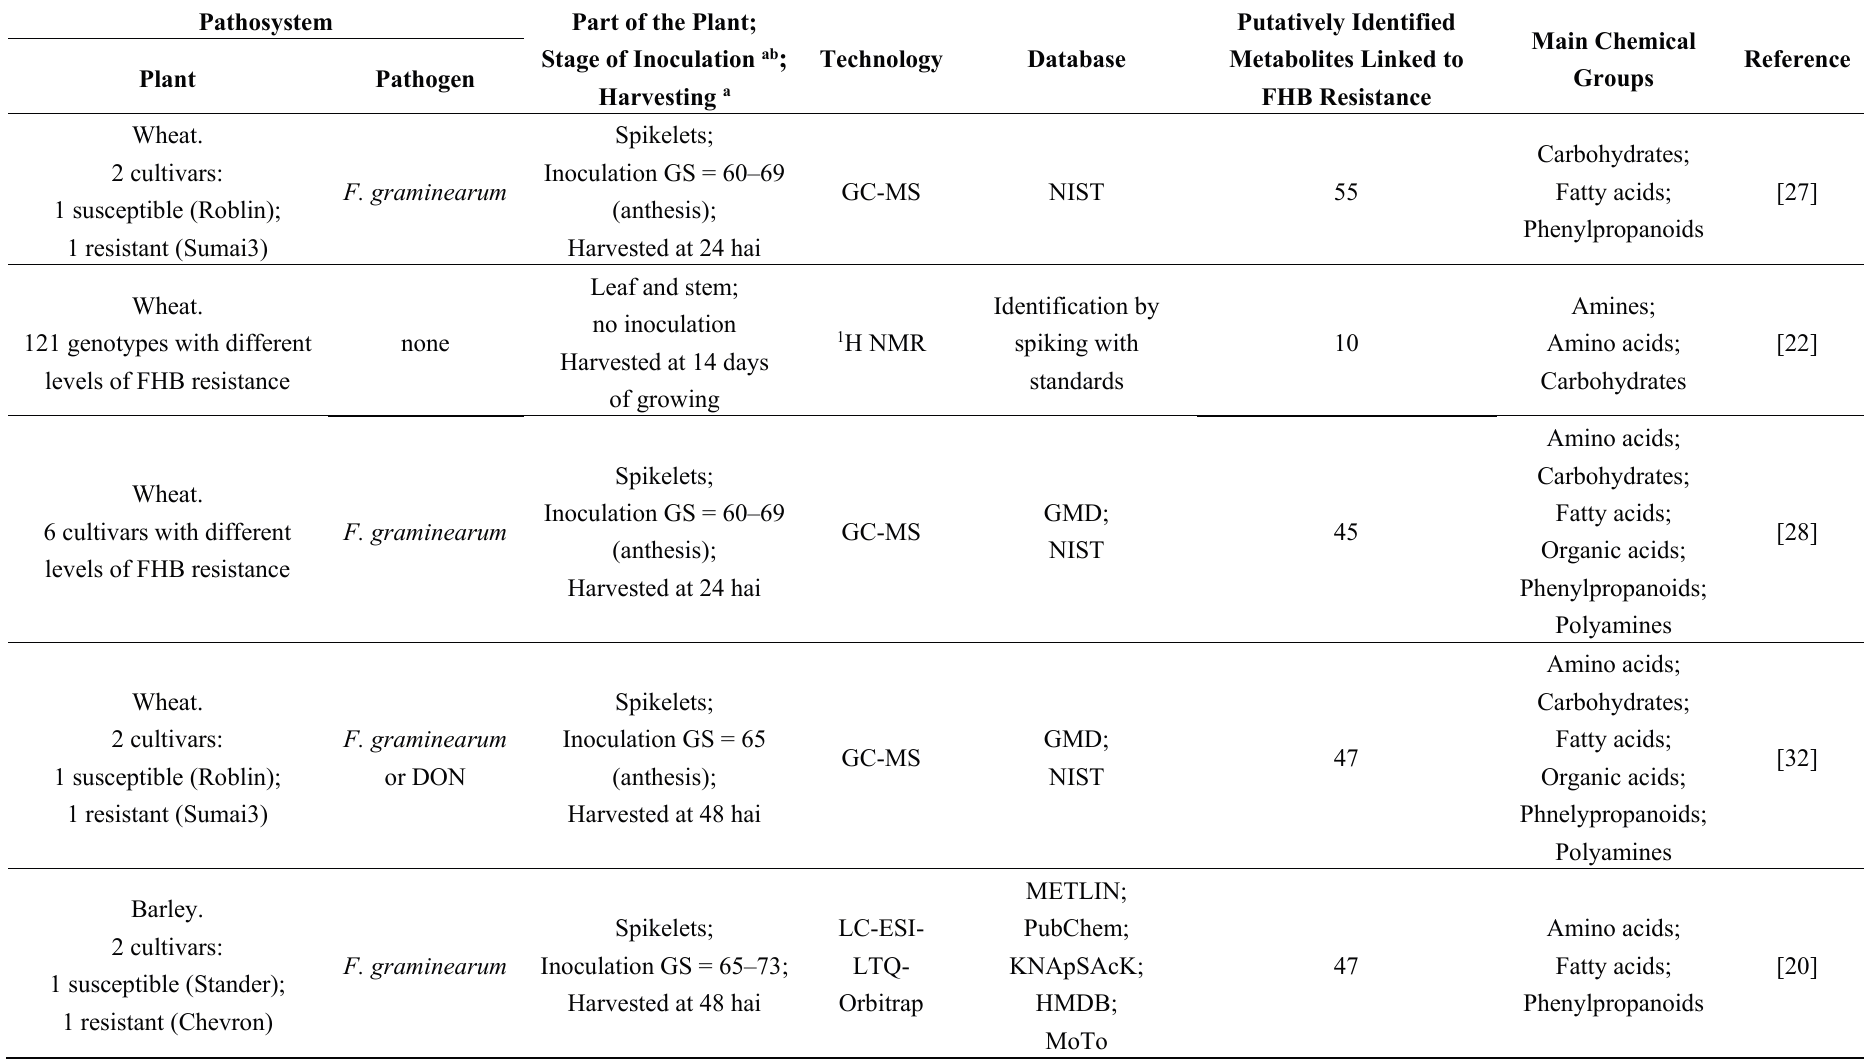
Table 1. Overview of metabolomic studies addressing the mechanisms of Fusarium head blight (FHB) resistance in wheat and